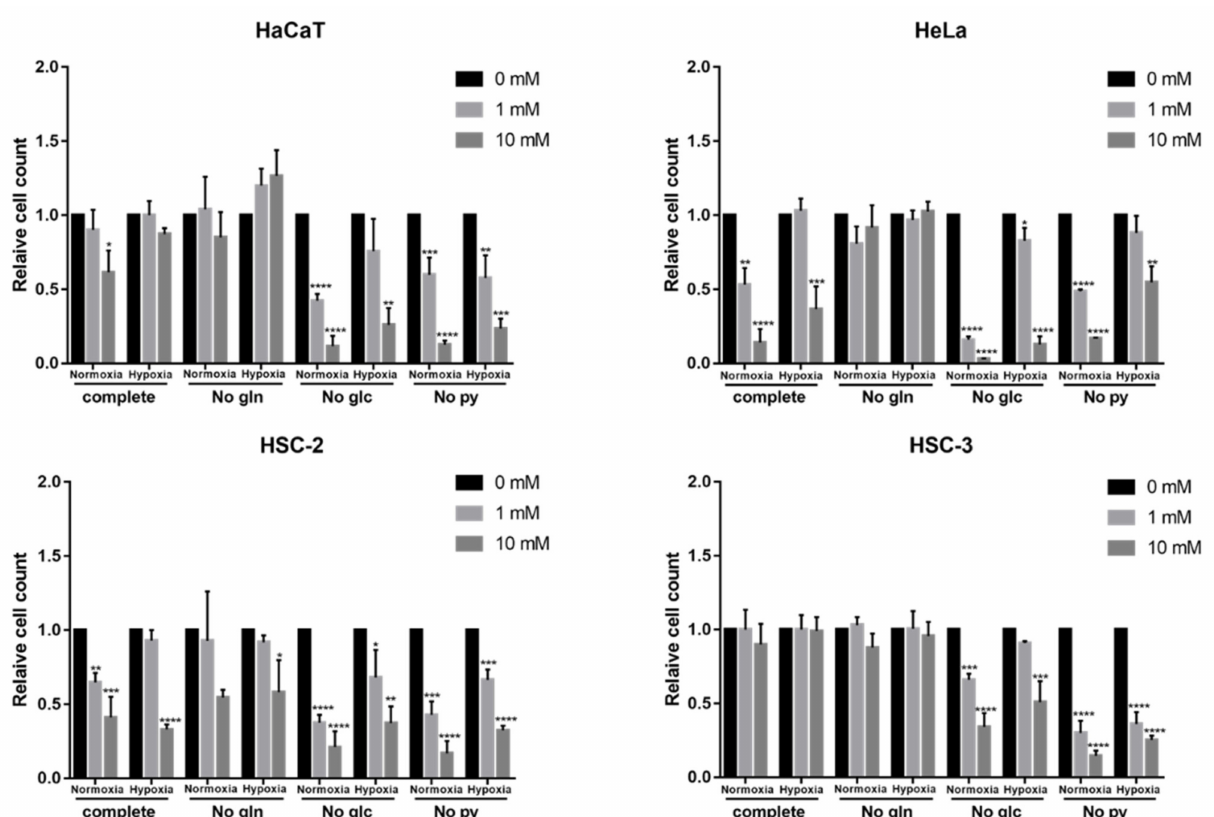
Figure 7. Effects of nutrient removal on metformin efficacy. Sensitivities of cell lines to metformin in complete medium (complete), glutamine-free medium (No gln), glucose-free medium (No glc), and pyruvate-free medium (No py) under normoxia and hypoxia. The relative cell count indicates the metformin group/control group. A one-way ANOVA and Tukey’s test. * p < 0.05, ** p < 0.01, *** p < 0.001, **** p < 0.0001. All experiments were independently performed in